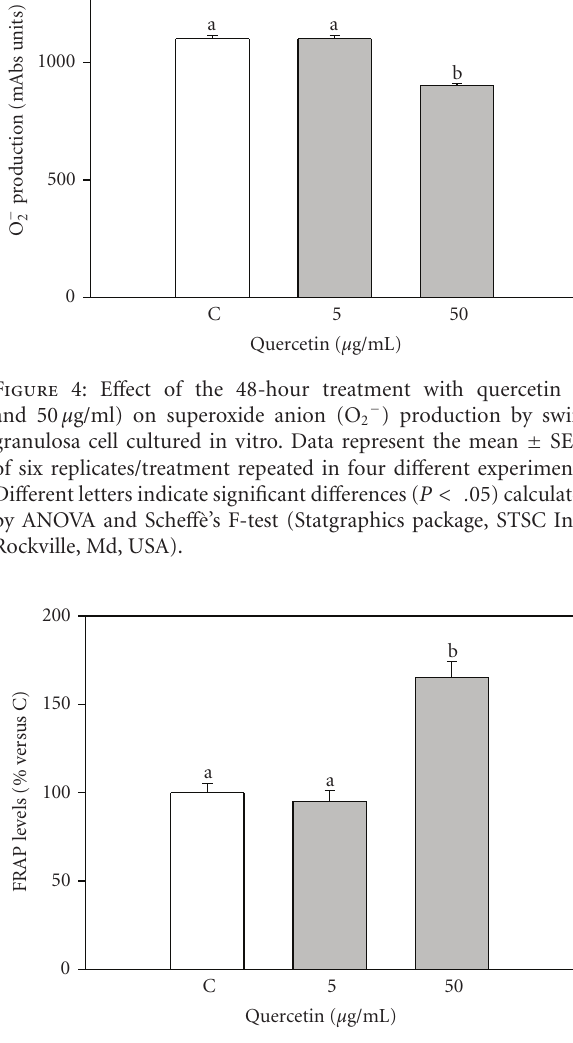
Figure 5: E ff ect of the 48-hour treatment with quercetin (5 and 50 μ g/ml) on Ferric Reducing Antioxidant Power (FRAP) levels in swine granulosa cell cultured in vitro. Data represent the mean ± SEM of six replicates/treatment repeated in four di ff erent experiments. Di ff erent letters indicate significant di ff erences ( P < . 001) calculated by ANOVA and Sche ff `e’s F-test (Statgraphics package, STSC Inc., Rockville, Md, USA).